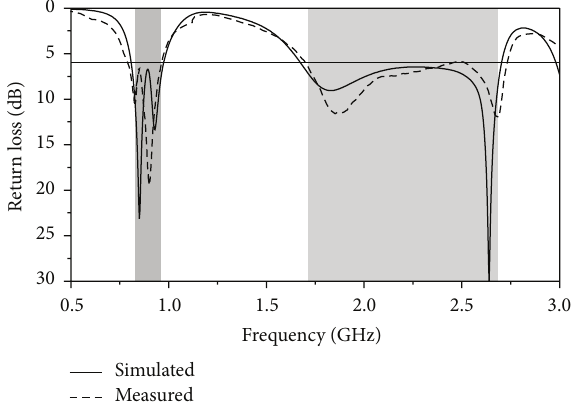
Figure 8: Photographs of the manufactured antenna.